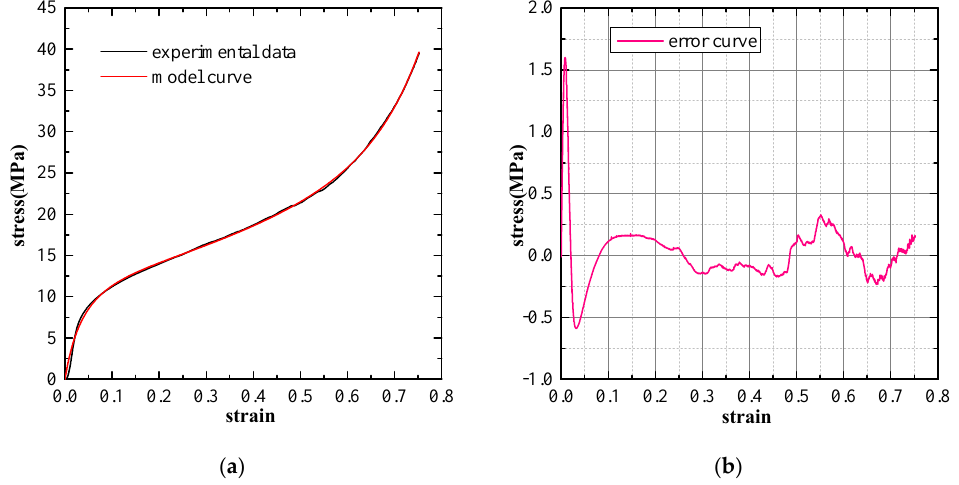
Figure 9. ( a ) Comparison between the curve predicted by the Liu and Subhash model and the experimental curve ( ρ ∗ / ρ s = 0.326); and ( b ) model prediction error.